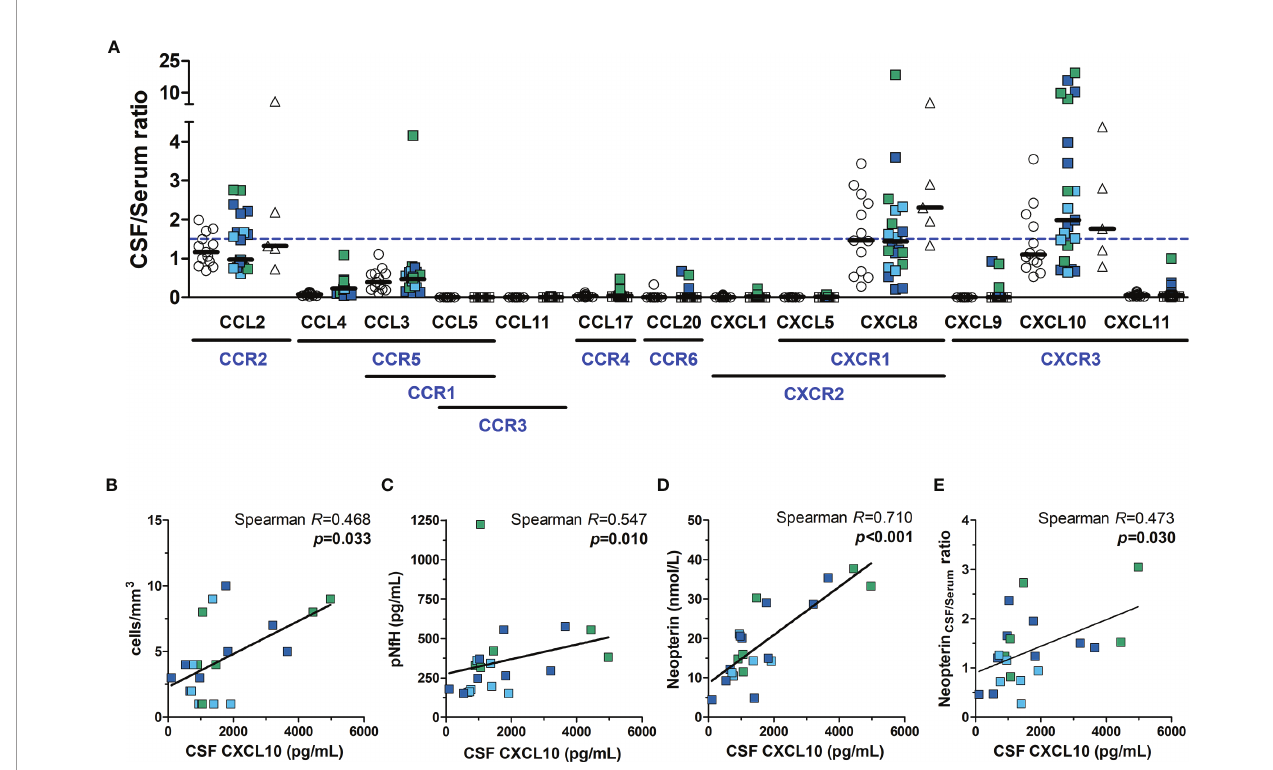
FIGURE 7 | Neuroin fl ammatory activity in HTLV-1 asymptomatic carriers (AC) and HAM/TSP patients. (A) The ratio between the CSF and serum concentration of chemokines was calculated, and values ≥ 1.5 (dashed blue line) indicated the direction of a positive gradient to control the migration of immune cells to the central nervous system. Chemokine receptors are shown in blue under their respective ligands. HAM/TSP patients were identi fi ed according to the speed of disease progression as very slow (light blue), typical/slow (dark blue) and rapid (green). Spearman ’ s correlation rank was used to evaluate the association between CSF levels of CXCL10 and (B) CSF cell counts, (C) phosphorylated neuro fi lament heavy chain (pNfH), (D) CSF levels of neopterin, and (E) the neopterin CSF/Serum ratio, and p - value < 0.05 was considered signi fi